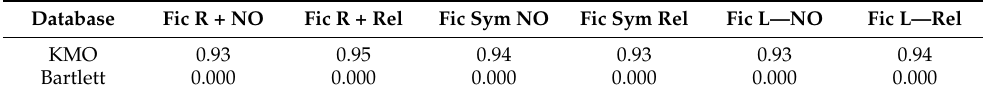
Table 5. Principal components